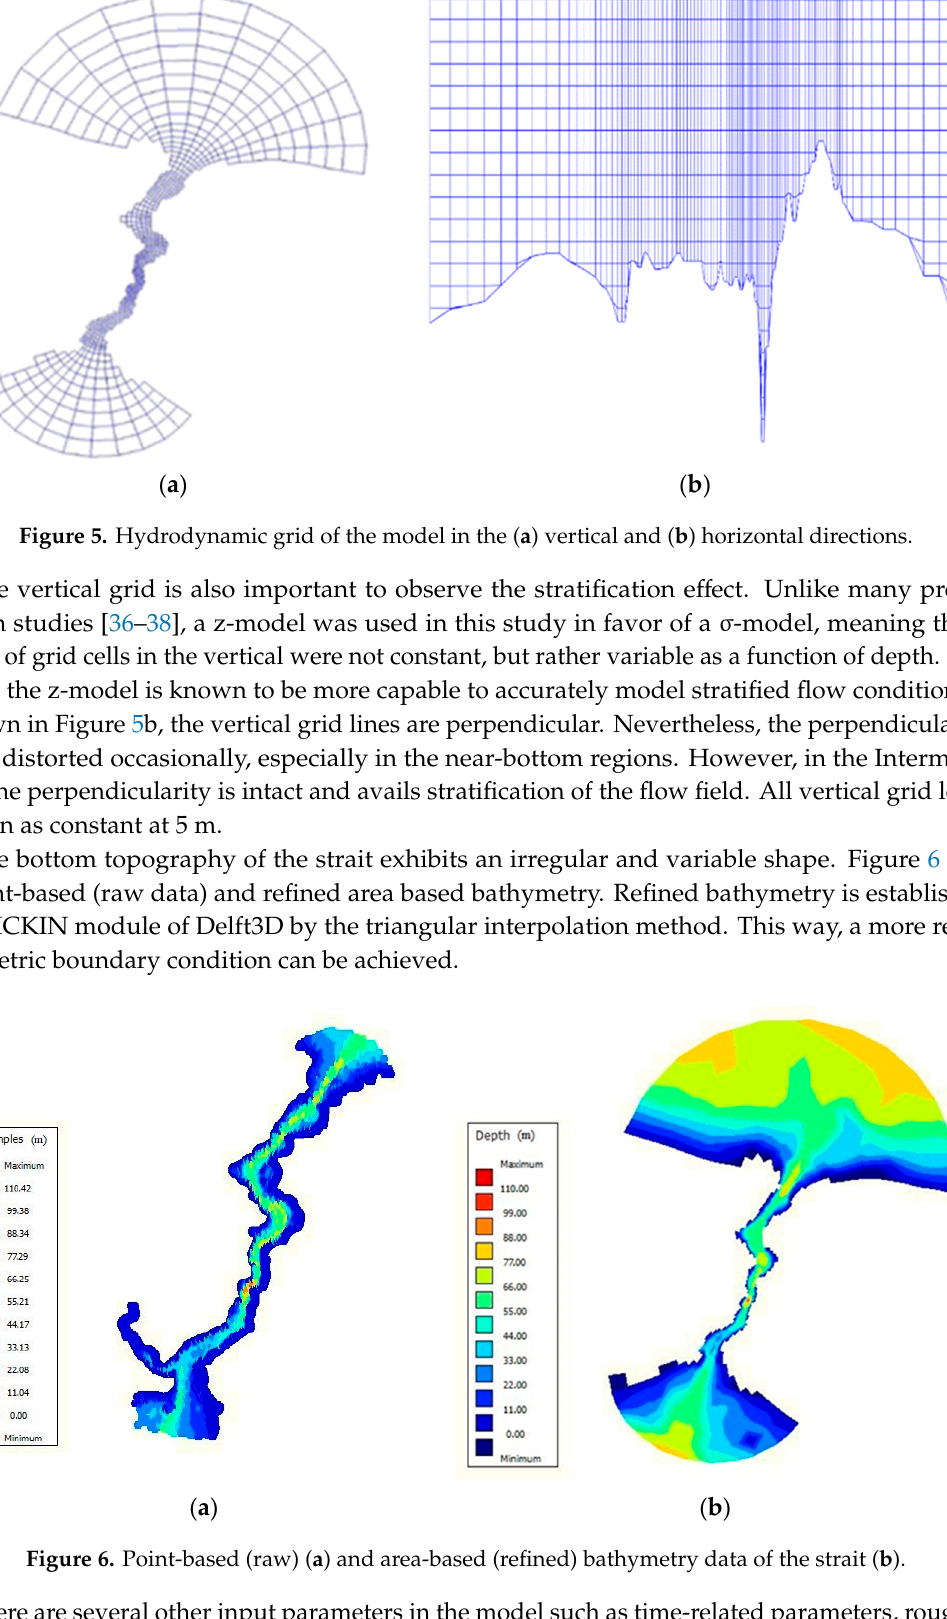
Figure 6. Point-based (raw) ( a ) and area-based (refined) bathymetry data of the strait ( b ).